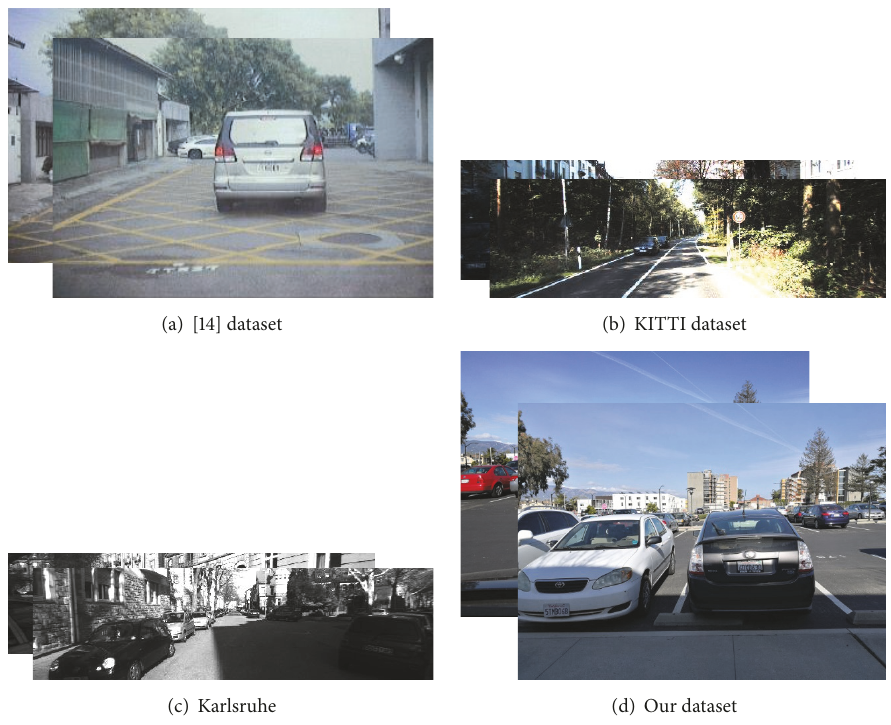
Figure 6: Image dataset used in this